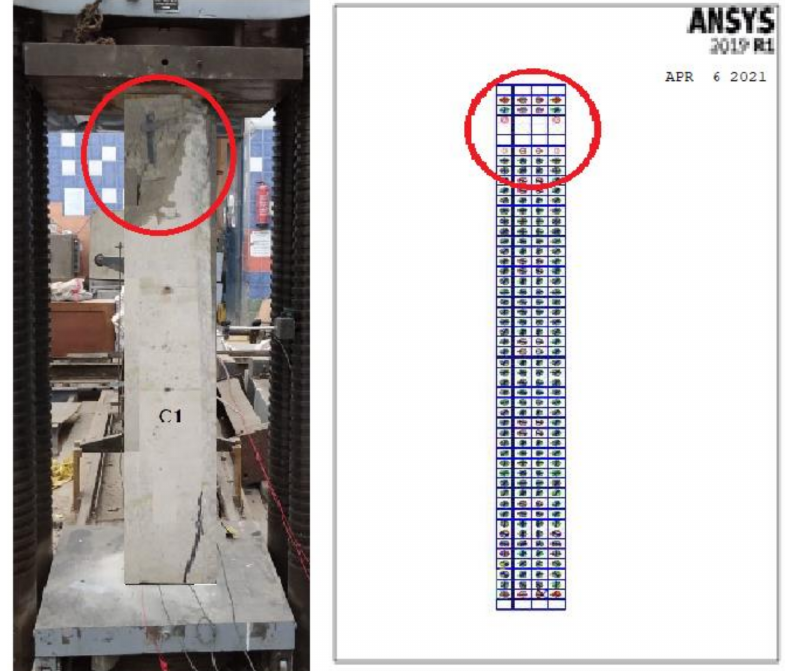
Figure 30. Crack spread for the control